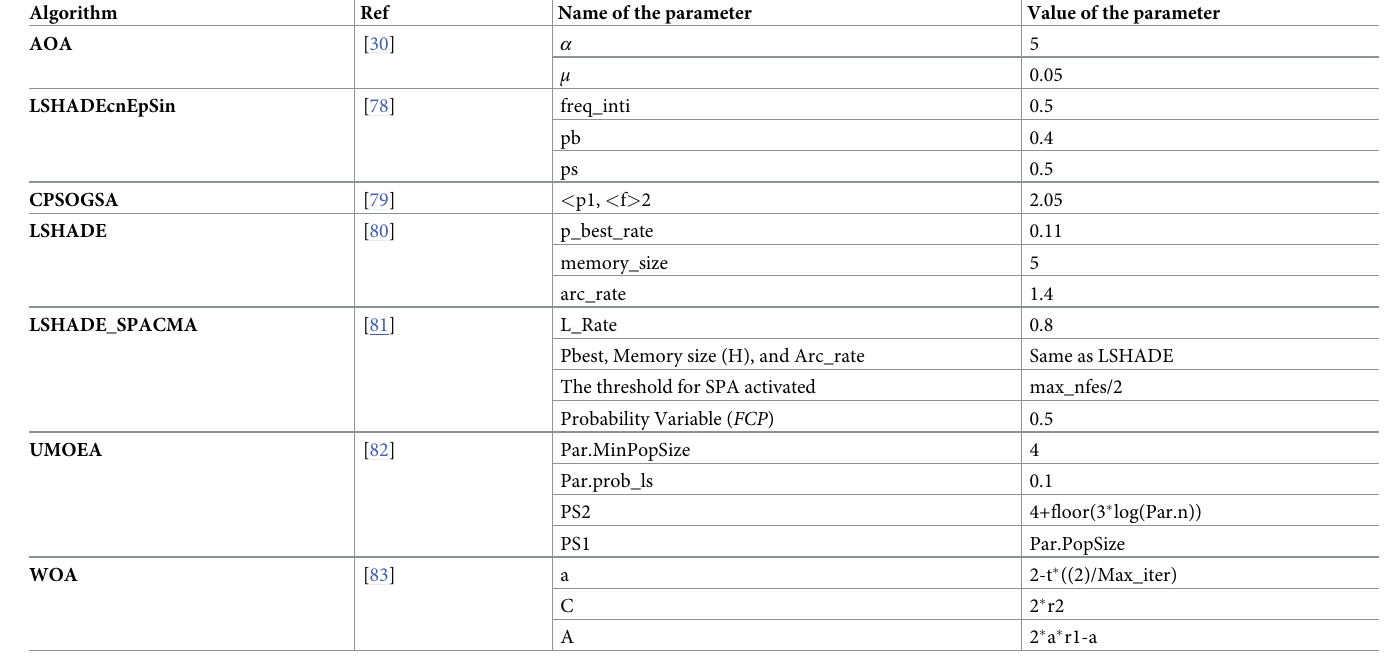
Table 5. Algorithm control